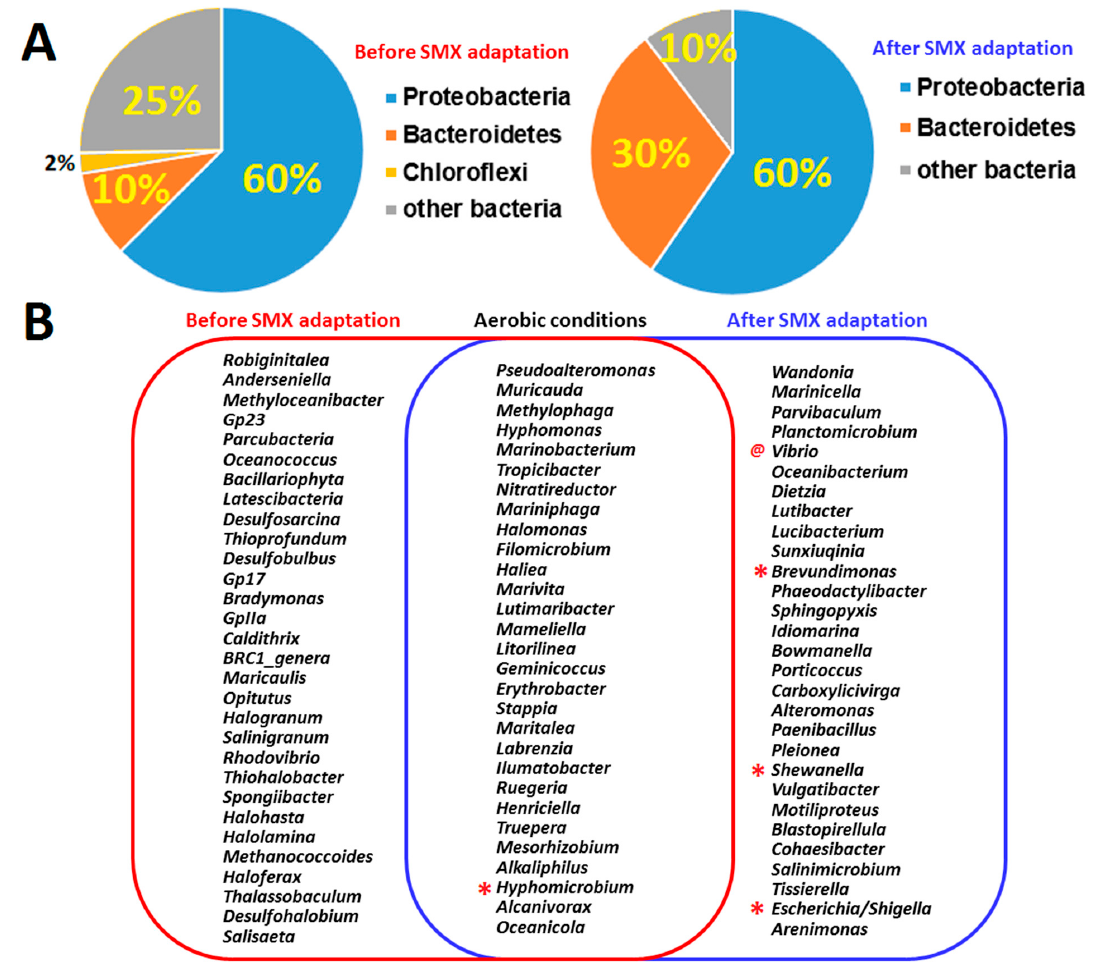
Figure 2. Bacterial / archaeal community in milkfish ( Chanos chanos ) pond sediments under aerobic condition before and after sulfamethoxazole (SMX) adaptation. ( A ) Major bacterial / archaeal community (phylum level) in the sediments under aerobic conditions before and after SMX adaptation. ( B ) Major bacterial / archaeal community (genus level) in the sediments under aerobic conditions before and after SMX adaptation. Red “@”s indicate SMX-degrading bacteria that were isolated in this study.